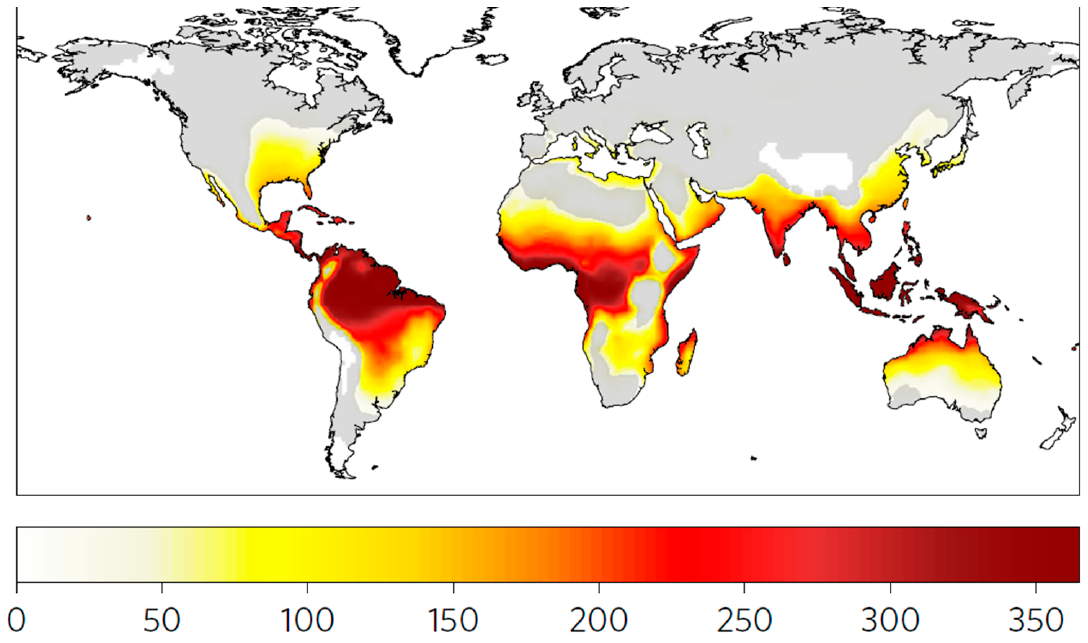
Figure 2. Global risk of deadly heat days with a Scale of annual overheated Days forecasting Climate Change in 2050 where residents need to stay in cooled areas to survive at least during the daytime. Adapted with permission from reference [22], Copyright 2017 Springer Nature.